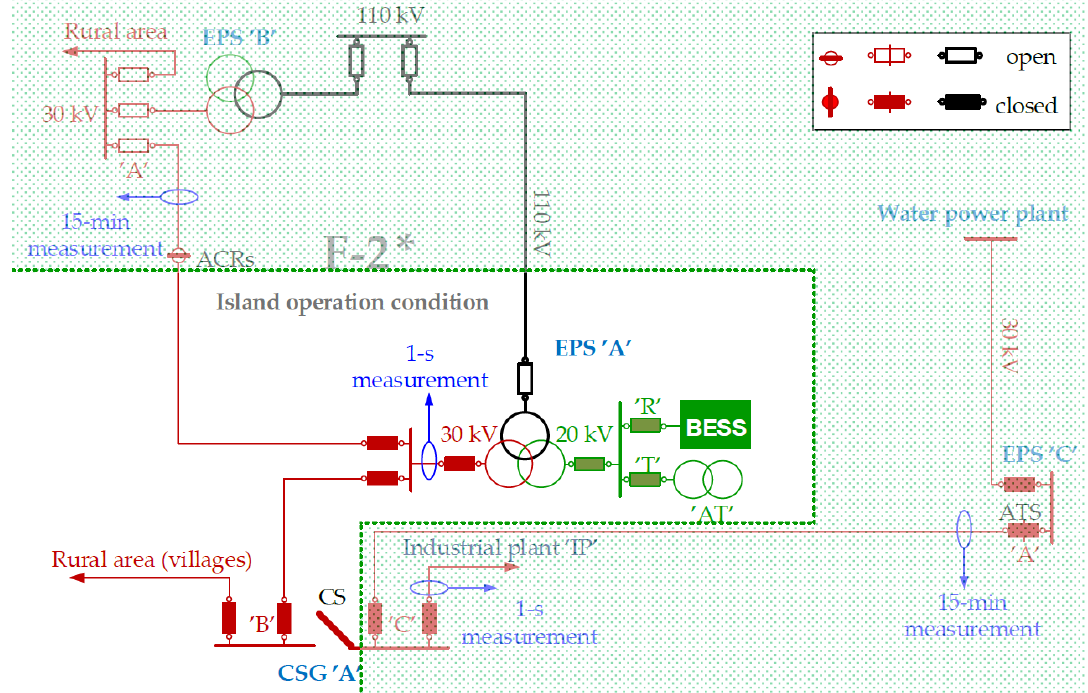
Figure 4. The system structure in the island operation condition F-2* . In the island operation condition F-2* , the BESS is connected to the reserve linear field “R” in the switchgear of the substation EPS “A”. The first place of the network divi- sion is the ACR, while the second is CS in the CSG “A”.